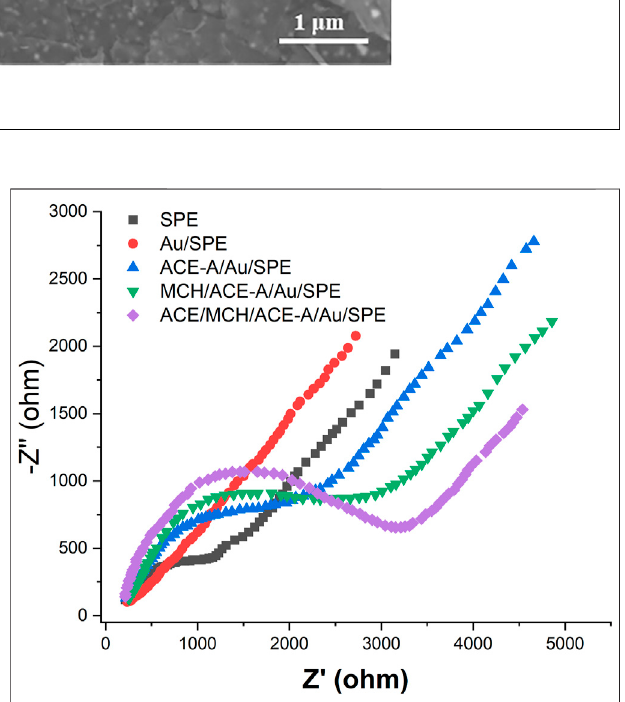
FIGURE 3 | EIS of SPE and Au/SPE with different CV cycles recorded in 5 mM [Fe(CN) 6 ] 3 − /4 − . FIGURE4| EISplotsofaptamersenorduringthefabricationrecordedin